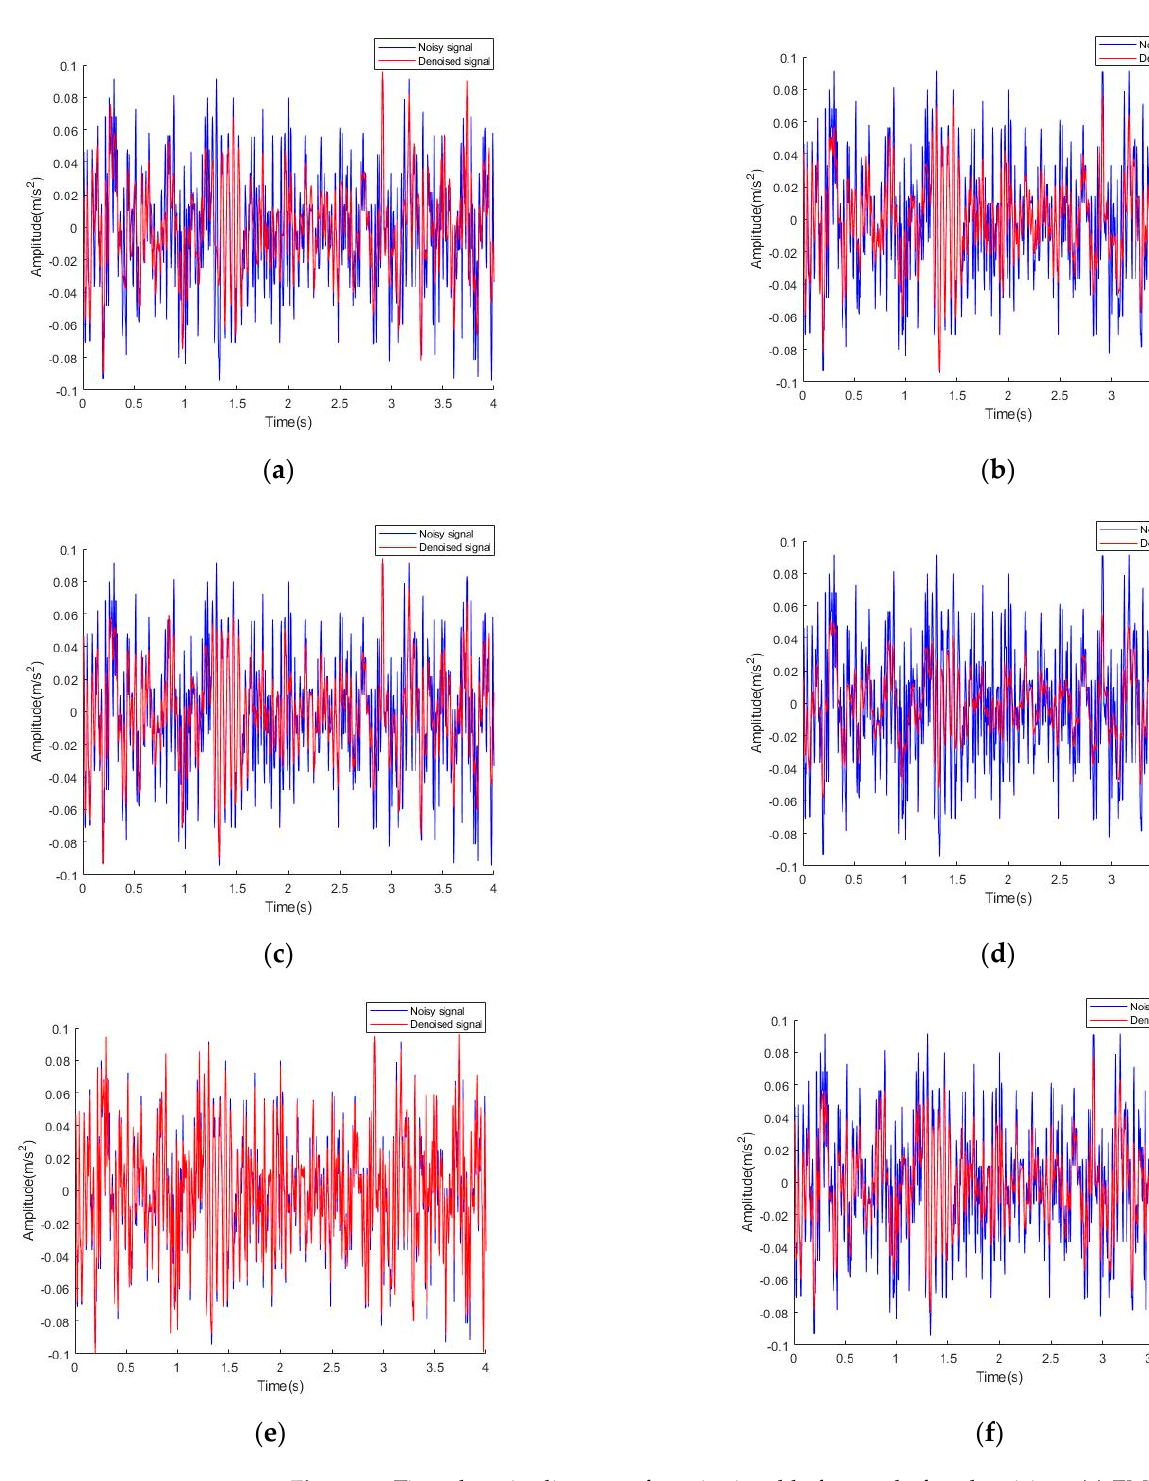
17 of 22 Figure 6. Signal acquisition device. ( a ) ( b ) Figure 7. Elevator horizontal vibration signal: ( a ) X -axis vibration signal; ( b ) Y -axis vibration signal.